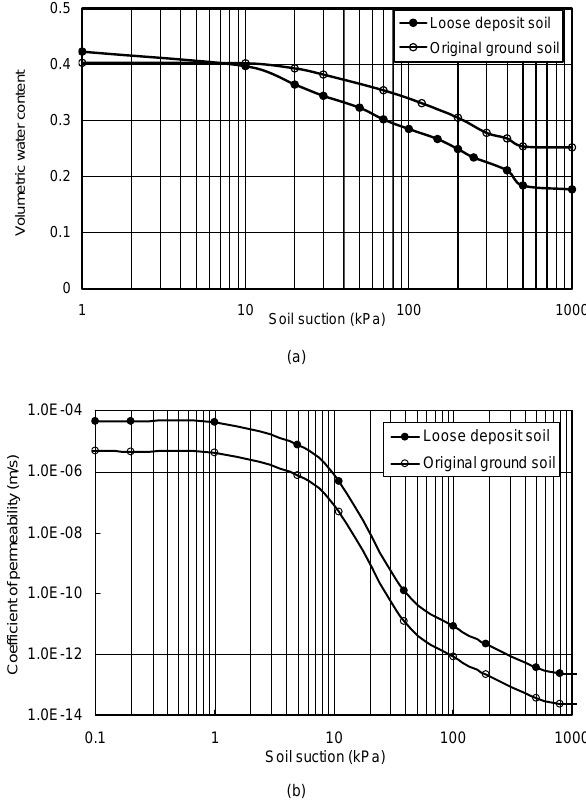
Fig. 9. Soil-water characteristic curves and permeability functions for seepage analysis.